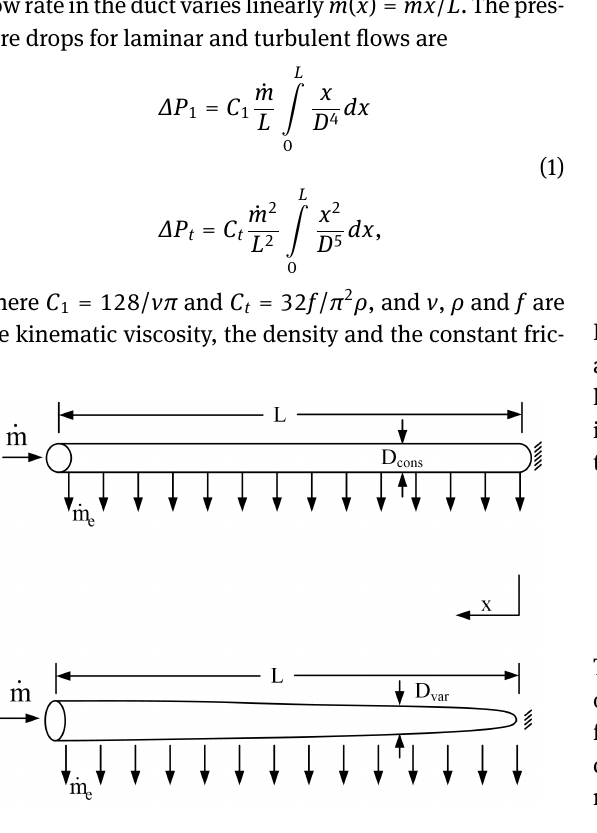
Figure 1: Supply duct with longitudinally distributed discharge: duct with constant diameter (top) and tapered duct